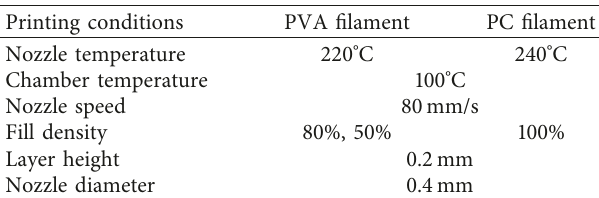
Figure 2: (a) FDM machine equipped with dual extruders and a thermostatic control chamber. 3D printed cubic samples for the solubility test of (b) external- and (c) internal-type supports. Table 1: Experimental conditions of FDM-based 3D printing of PVA and PC filaments for the solubility